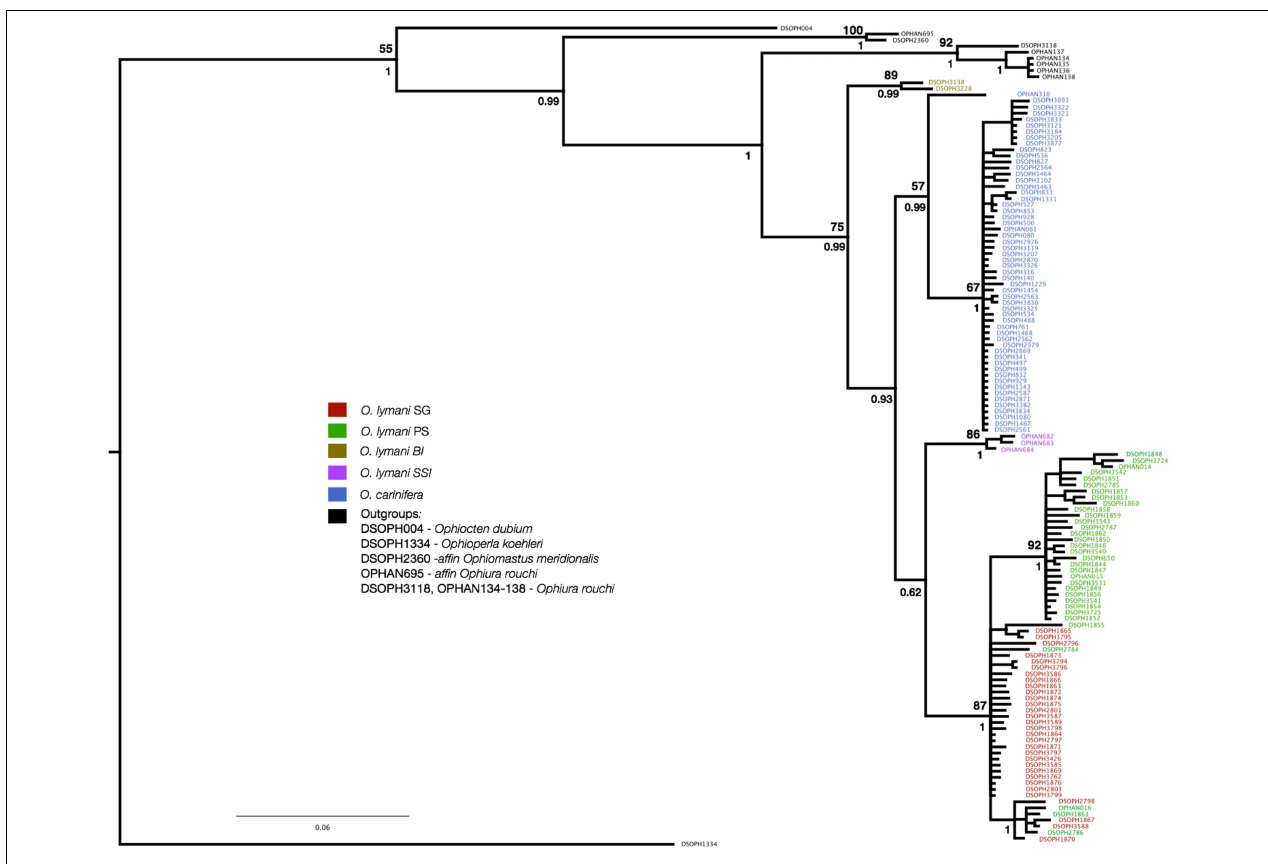
samples are black. Posterior probabilities are given under the line by the associated adjacent node and bootstrap values are given above the line. No value was given if bootstrap was less than 50%. The identifiers on the tips are BOLD system accession numbers for the individual sequences.